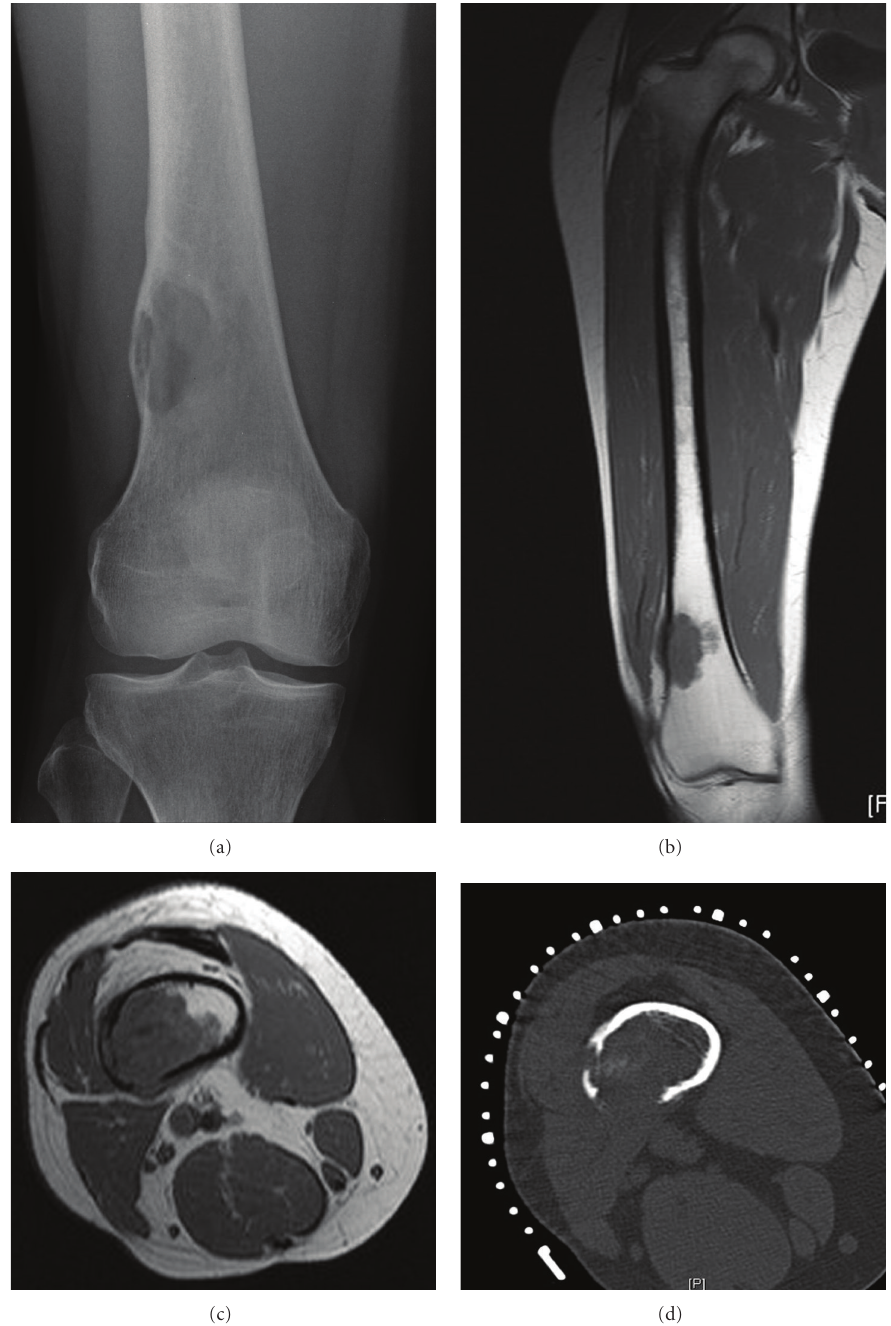
Figure 1: Radiological appearance of LGCO: a patient presented with a solitary bone lesion (a). MRI demonstrated an intermediate signal intraosseous lesion relative to skeletal muscle on T1 (b) and (c). CT-guided biopsy was undertaken (d). The lesion had marked cortical involvement with extraosseous